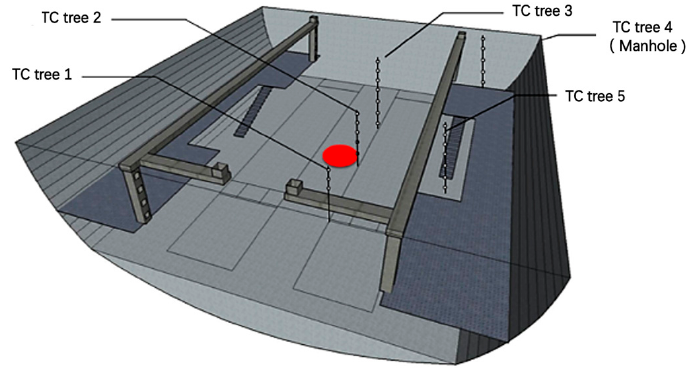
Figure 2. Schematic diagram of fire source and thermocouple layout.